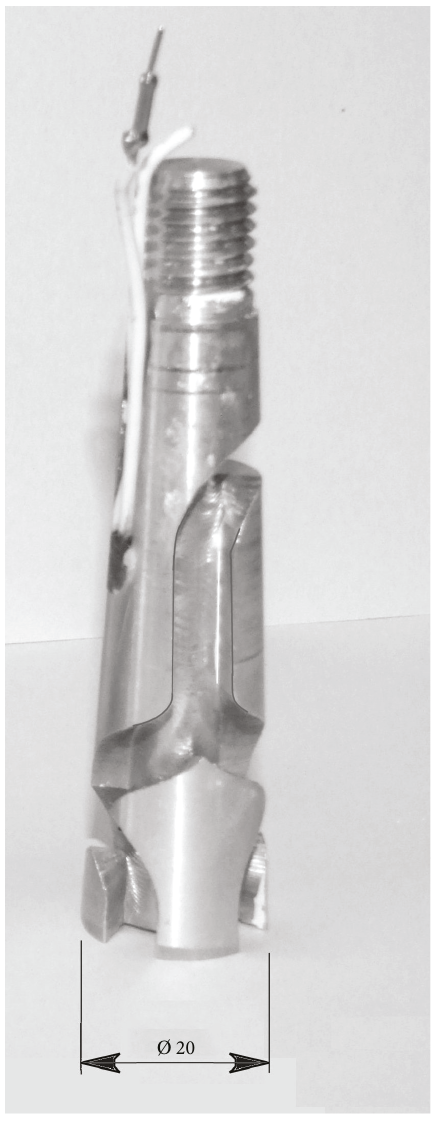
Figure 10: Photograph of the inner cone body with the grooves distributing the detonation wave into the four exits. Bifurcating fl ow trajectories in this case correspond to Figure